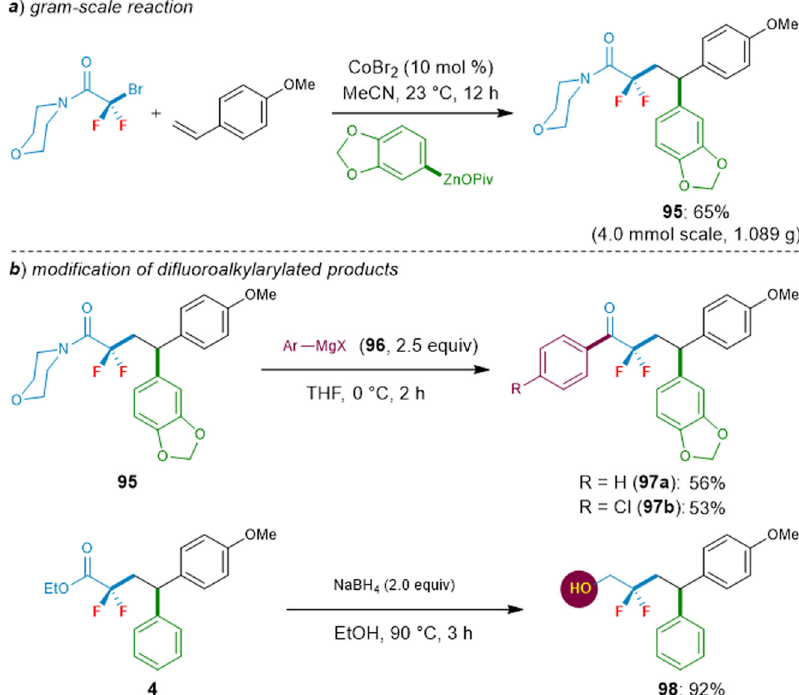
Fig. 7 Applications. a Gram-scale reaction. b Modi fi cation of di fl uoroalkylarylated